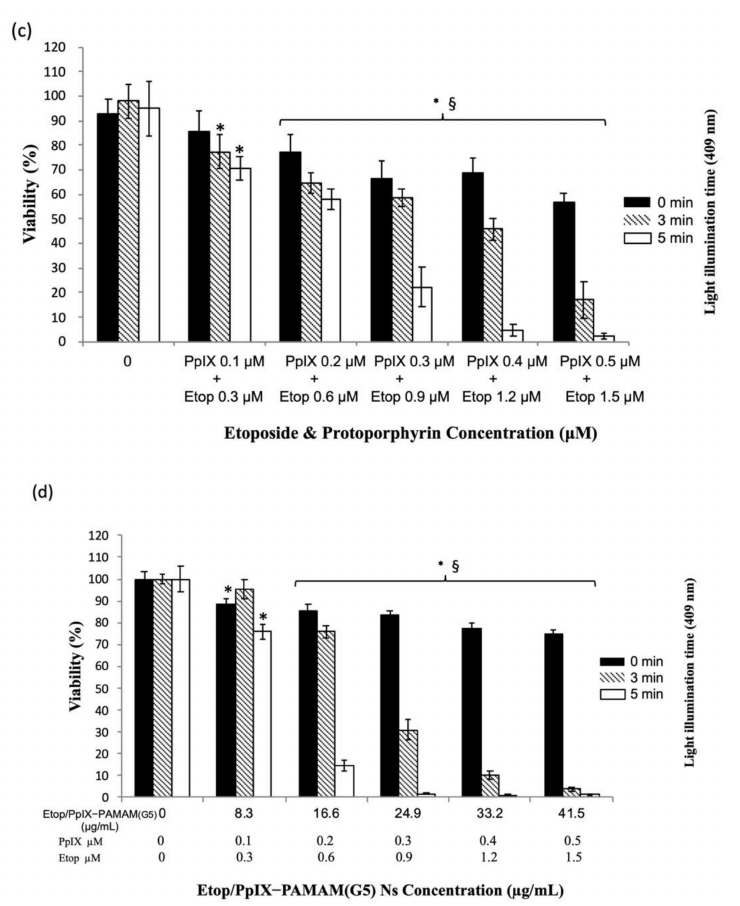
Figure 4. The MTT assay was performed 48 h after treatment of U87-MG cells with different drug concentrations and light illumination times. ( a ) The effect of Etop appeared to abate with dose escalation towards 20 µ M, reaching a maximal cytotoxicity of approximately 50%. ( b ) PDT with PpIX alone lead to significant dose-dependent cytotoxicity, reaching greater than 95% cytotoxicity from 0.5 µ M of PpIX and beyond. Illumination-time dependence was observed from 0.2 µ M to 0.4 µ M, whereas dark toxicity was not encountered in the concentration range tested (0.1 µ M to 2.5 µ M). ( c ) Phototherapy using co-administered Etop and PpIX led to significant cytotoxicity which was both dose- and illumination time-dependent. ( d ) Phototherapy using Etop/PpIX-PAMAM(G5) Ns also revealed significant effects which were both dose- and illumination-time dependent. * p < 0.05 (versus control). § p < 0.05 (same dose of Etop and PpIX or Etop/PpIX-PAMAM(G5) Ns versus